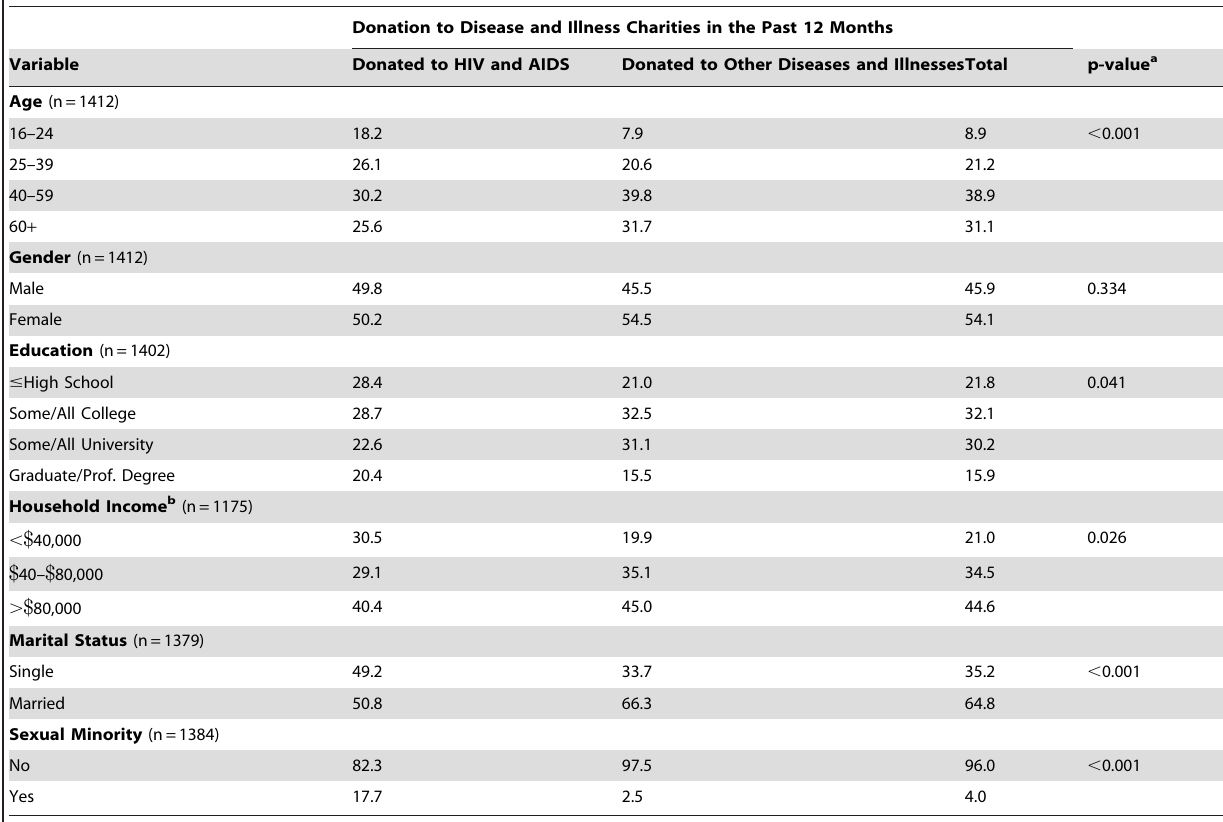
Table 4. Socio-Demographic Associations with Participants who Donated to HIV and AIDS versus Other Disease or Illness Charities in the Past 12 Months (n =1412, Weighted %).